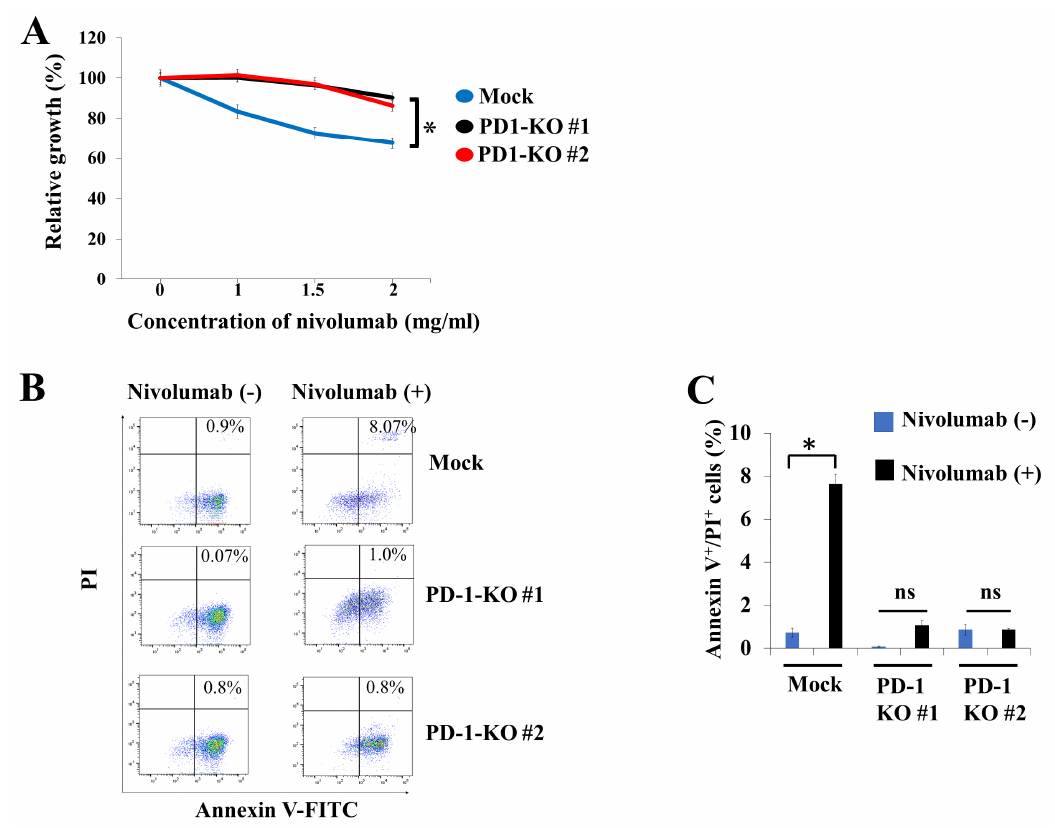
Figure 5. Nivolumab inhibited cell proliferation via induction of direct apoptosis in VAL/mock cells compared with VAL/PD-1-KO cells. ( A ) MTT assay showing the relative growth rate of VAL/mock and VAL/PD-1-KO cell clones in the presence of 1 mg/mL of nivolumab alone after 48 h (blue, VAL/mock; black and red, VAL/PD-1-KO cell clones). Nivolumab inhibited cell proliferation of VAL/mock cells compared with that of VAL/PD-1-KO cells. The relative optical density (OD) at 595 nm on each indicated day was normalized to (divided by) that on day 0. ( B , C ) Nivolumab induced direct apoptosis in VAL/mock cells while it did not in VAL/PD-1-KO cell clones. ns, not significant; * p < 0.005. PD-1, programmed